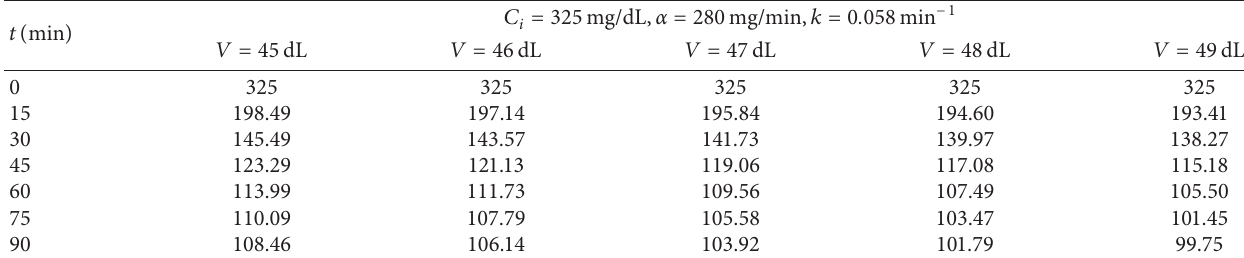
Table 4: Blood glucose concentration C ( t ) for different values of volume in which glucose is distributed V and time t with C